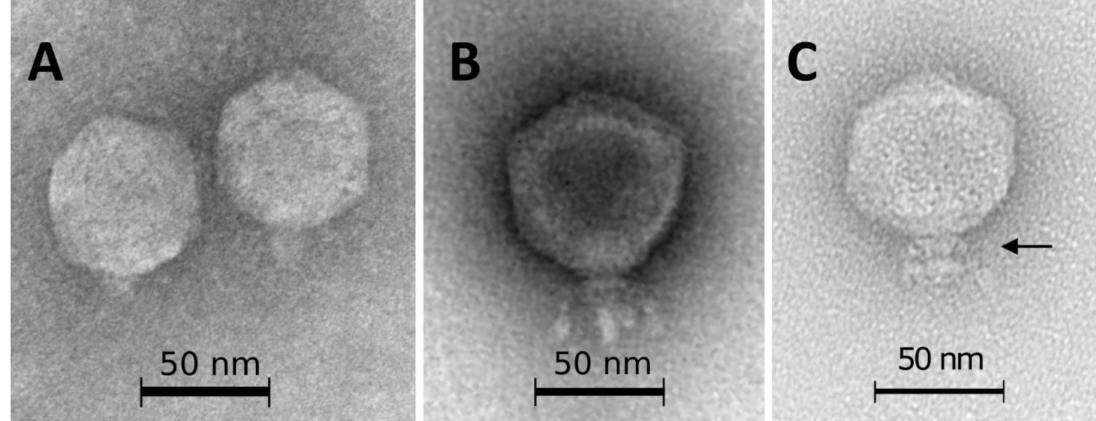
Figure 7. ( A ) Transmission electron microscopy of Pectobacterium phage Arno160 ( Autographiviridae family) [101], ( B ) Pectobacterium phage vB_PatP_CB4 ( Schitoviridae family) [130], ( C ) Dickeya phage Amaethon ( Kafunavirus genus); ( C ) [101]. The scale bar is 50 nm. The arrow points to the collar structure beneath the capsid. The images were obtained with the kind permission of the authors and publishers of the cited